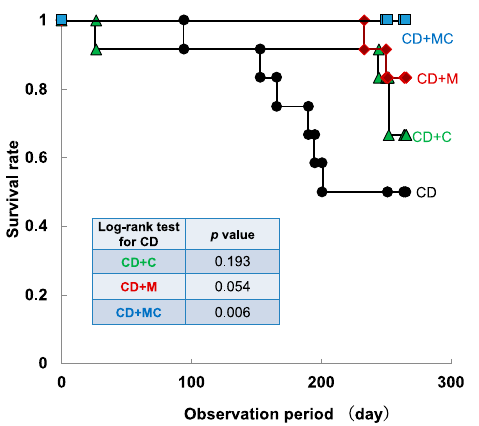
Figure 1. Experimental protocol. Table 1. Ingestion of CCP or MFGM.